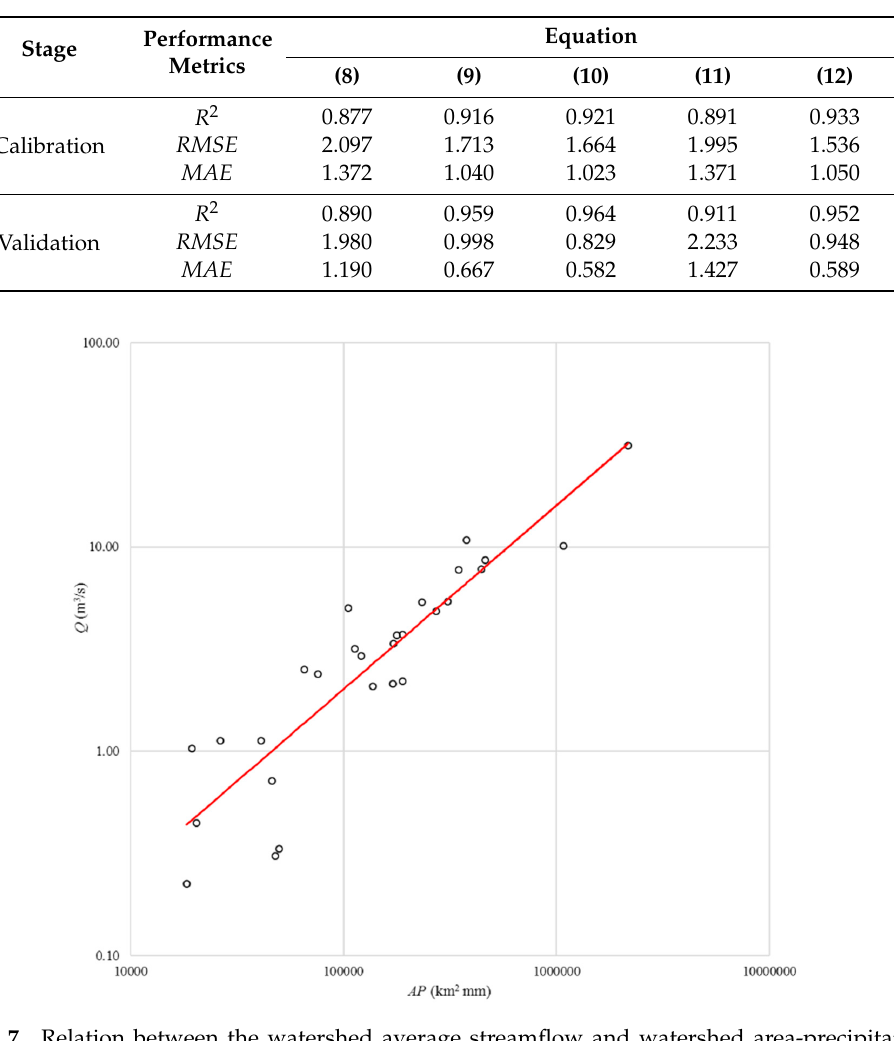
Table 9. Performance criteria calculated for the watershed average streamflow.